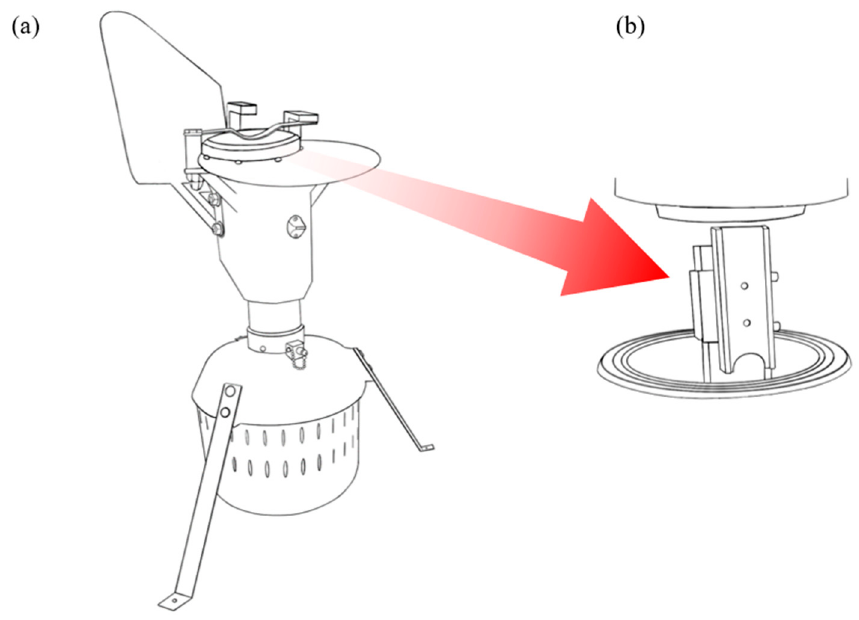
Figure 2. Schematic of Hirst-type 24-h Burkard pollen and spore trap ( a ) and internal microscope slide holder ( b